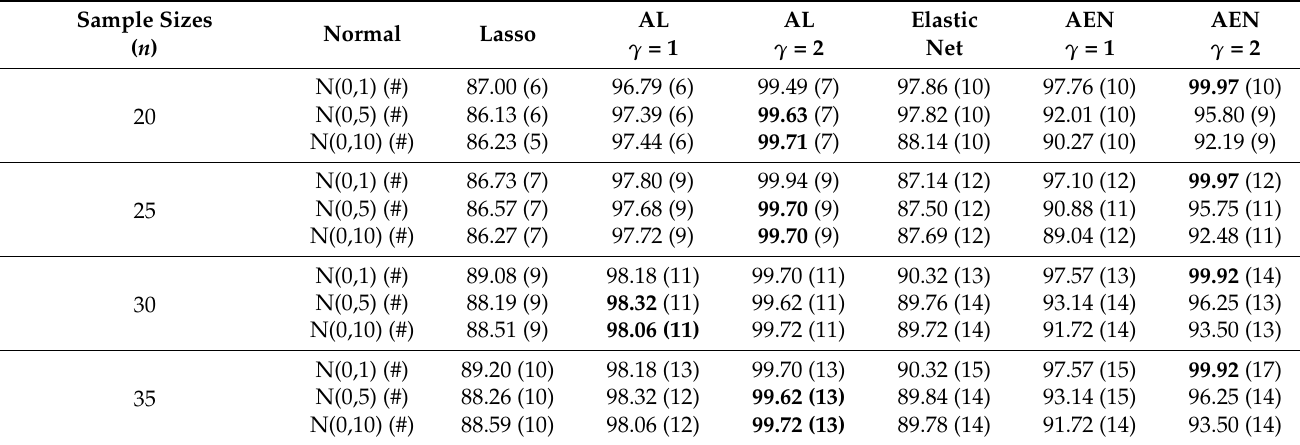
Table 4. The average percentage of accuracy and the average number of selected variables (#) of lasso, adaptive lasso (AL), elastic net, and adaptive elastic net (AEN) under 40 variables.